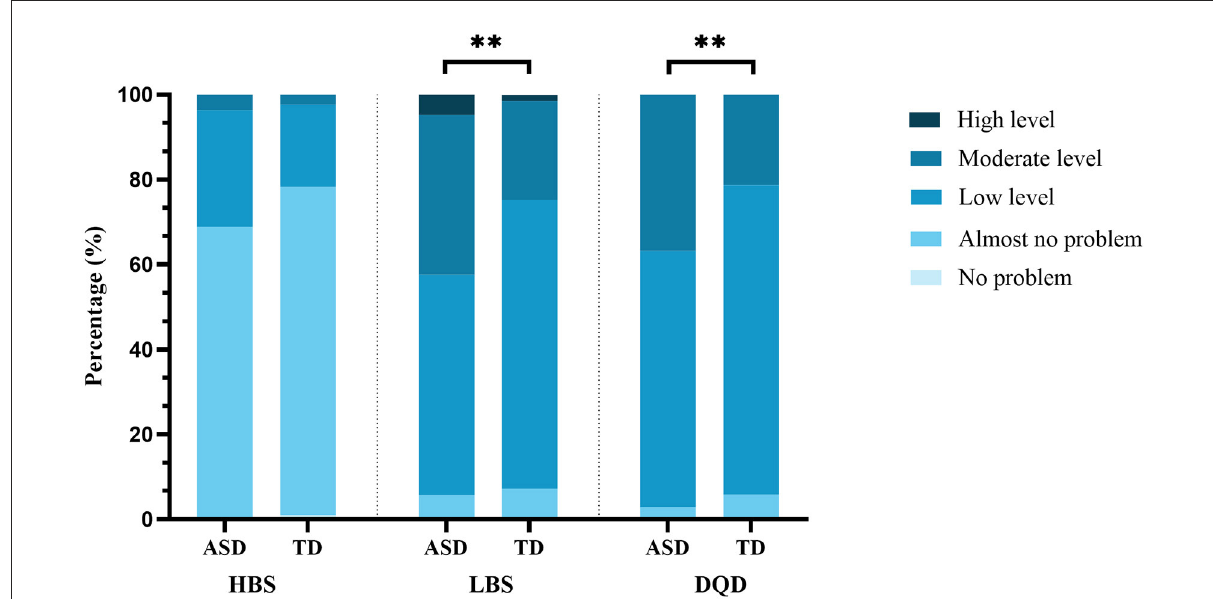
FIGURE1 Comparison of DBI_16 indicators among children with ASD and TD children. ASD, autism spectrum disorder; TD, typically developing; LBS, Low Bound Score; HBS, High Bound Score; DQD, Diet Quality Distance. ** P <